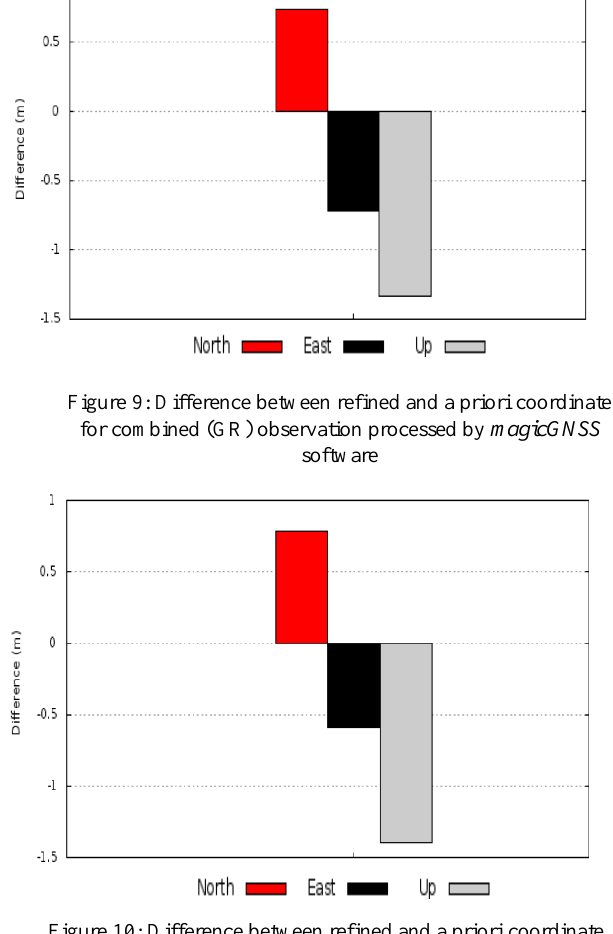
Figure 10: Difference between refined and a priori coordinate for G only observation processed by magicGNSS